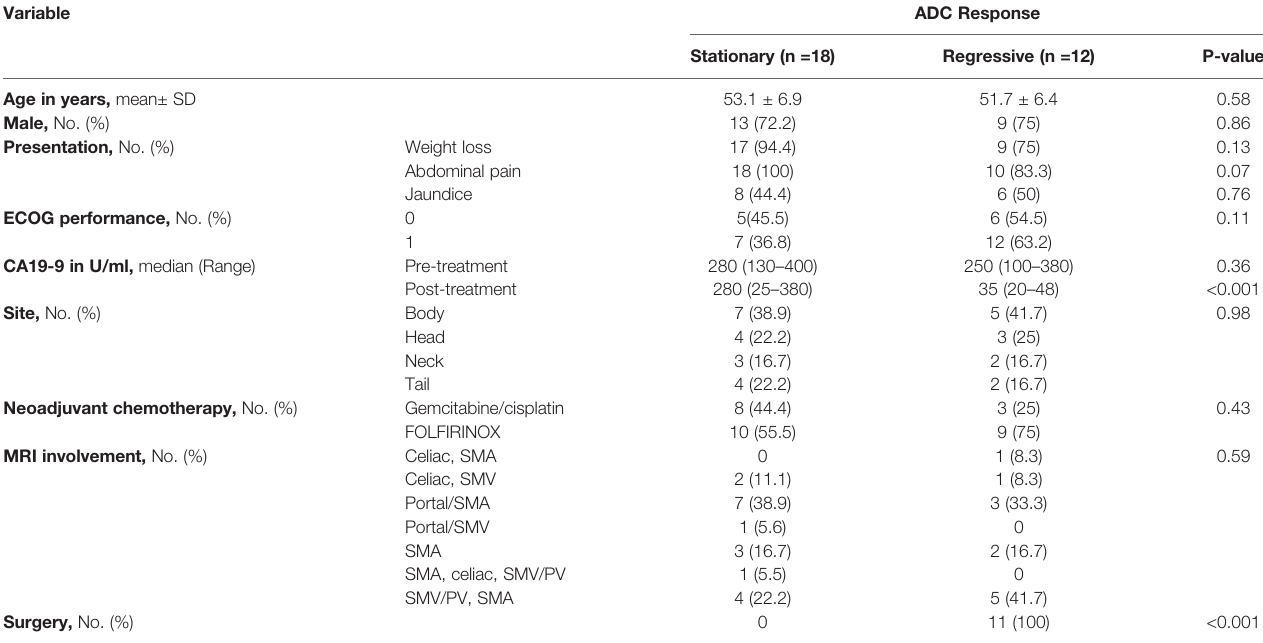
TABLE 5 | Association between ADC response and characteristics of the study population (n